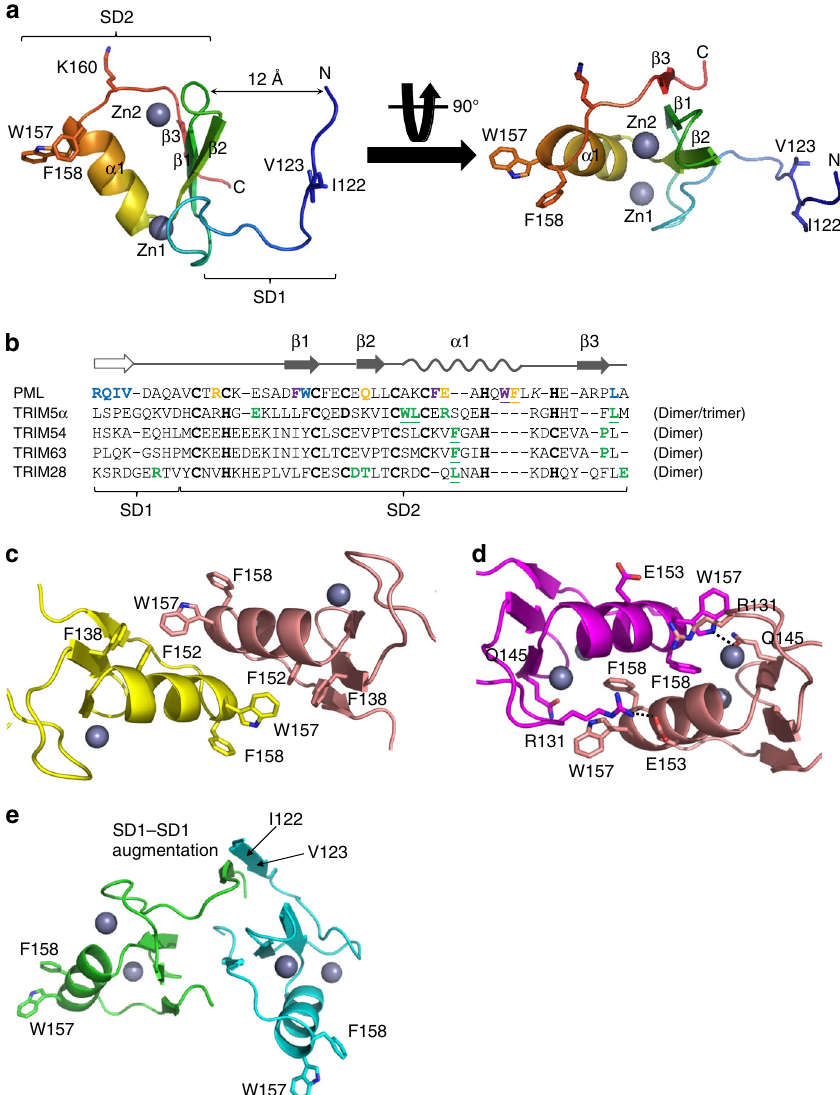
Fig. 2 Crystal structure of PML B1-box multimers. a B1-box monomer. The crystallographic monomer containing residues 120 – 167 is shown in cartoon representation. From N- to C-terminus, the structure is colored using the rainbow scheme implemented in Pymol. I122, V123, W157, F158, and K160 are shown in stick representation. The Zn1 and Zn2 ions are shown in sphere representation. The subdomain 1 (SD1) and subdomain 2 (SD2) are bracketed. b Sequence alignment of B-box driven oligomerization. The secondary structures of PML B1-box are shown on top of the sequences. An empty arrow is used to highlight the loop-to-strand conversion during SD1-augmentation (see below, Fig. 2e). The highly conserved Zn-binding residues are highlighted with bold font. The residues, which are involved in W157-, F158-, and SD1-dimerizations, are colored in purple, yellow, and blue, respectively. The residues, which are observed in other TRIM oligomerizations, are colored in green. In particular, the conserved hydrophobic interactions in α 1 helices (Supplementary Fig. 2b) are underlined. c W157-dimer. The residues W157, F138, and F152 in the dimeric cleft are shown in stick representations. d F158-dimer. The auxiliary hydrogen bonds surrounding F158 – F158 are shown in dashed lines. e SD1-interface. The residues I122 and V123 that lie in the heart of SD1- augmentation are highlighted with